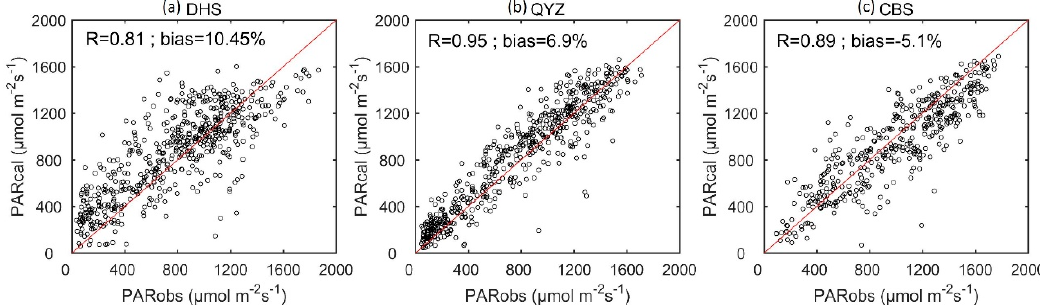
Figure 4. Comparisons between in-situ measured PAR and estimated PAR (dSW*1.70). dSW is surface downward shortwave radiative fluxes from CERES SSF in all sky conditions.